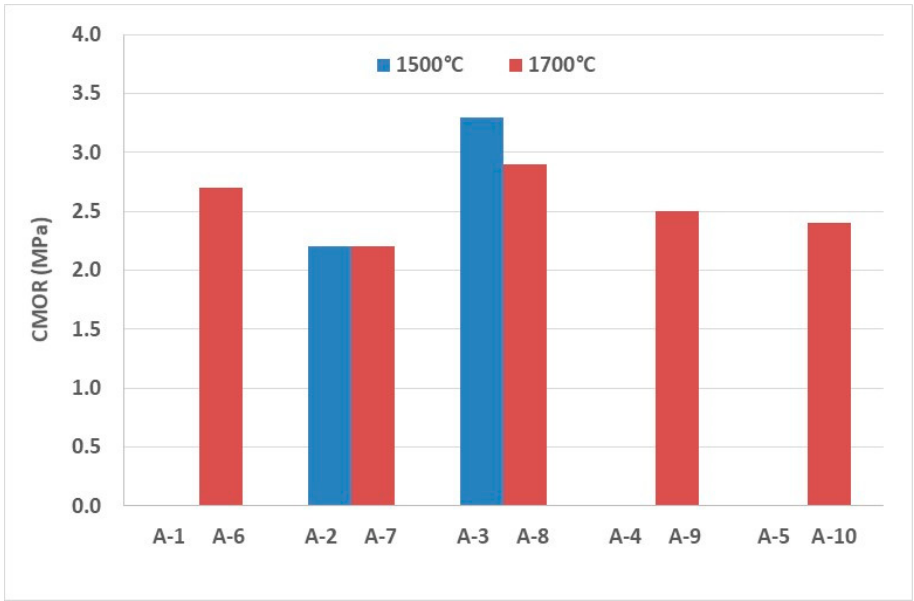
Figure 5. Cold modulus of rupture of magnesia–spinel brick compositions after the sandwich coating test.